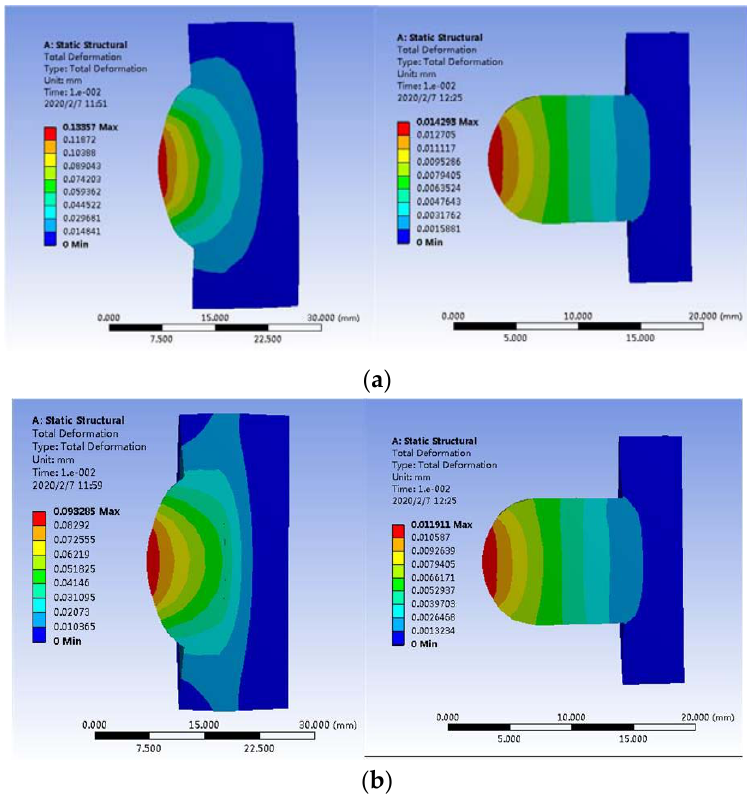
Figure 6. Deformation of upper and the lower caps: ( a ) before optimization and ( b ) after optimization.